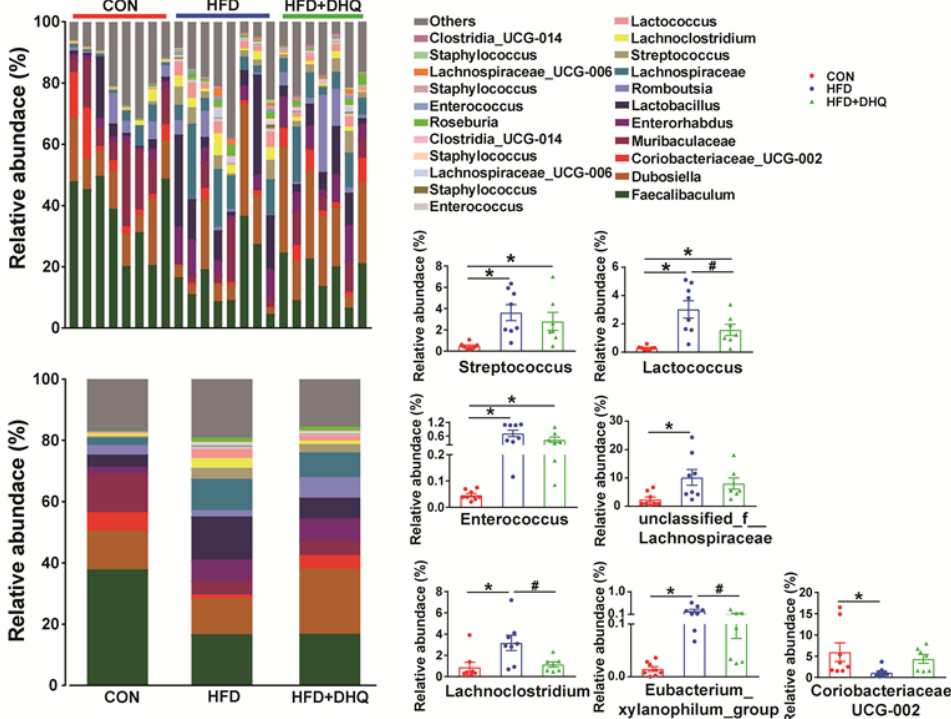
Figure 9. Effects of DHQ supplementation on fecal microbial composition at genus level in mice. Data were expressed as the mean ± SEM. * p < 0.05 vs. CON group, # p < 0.05 vs. HFD group.